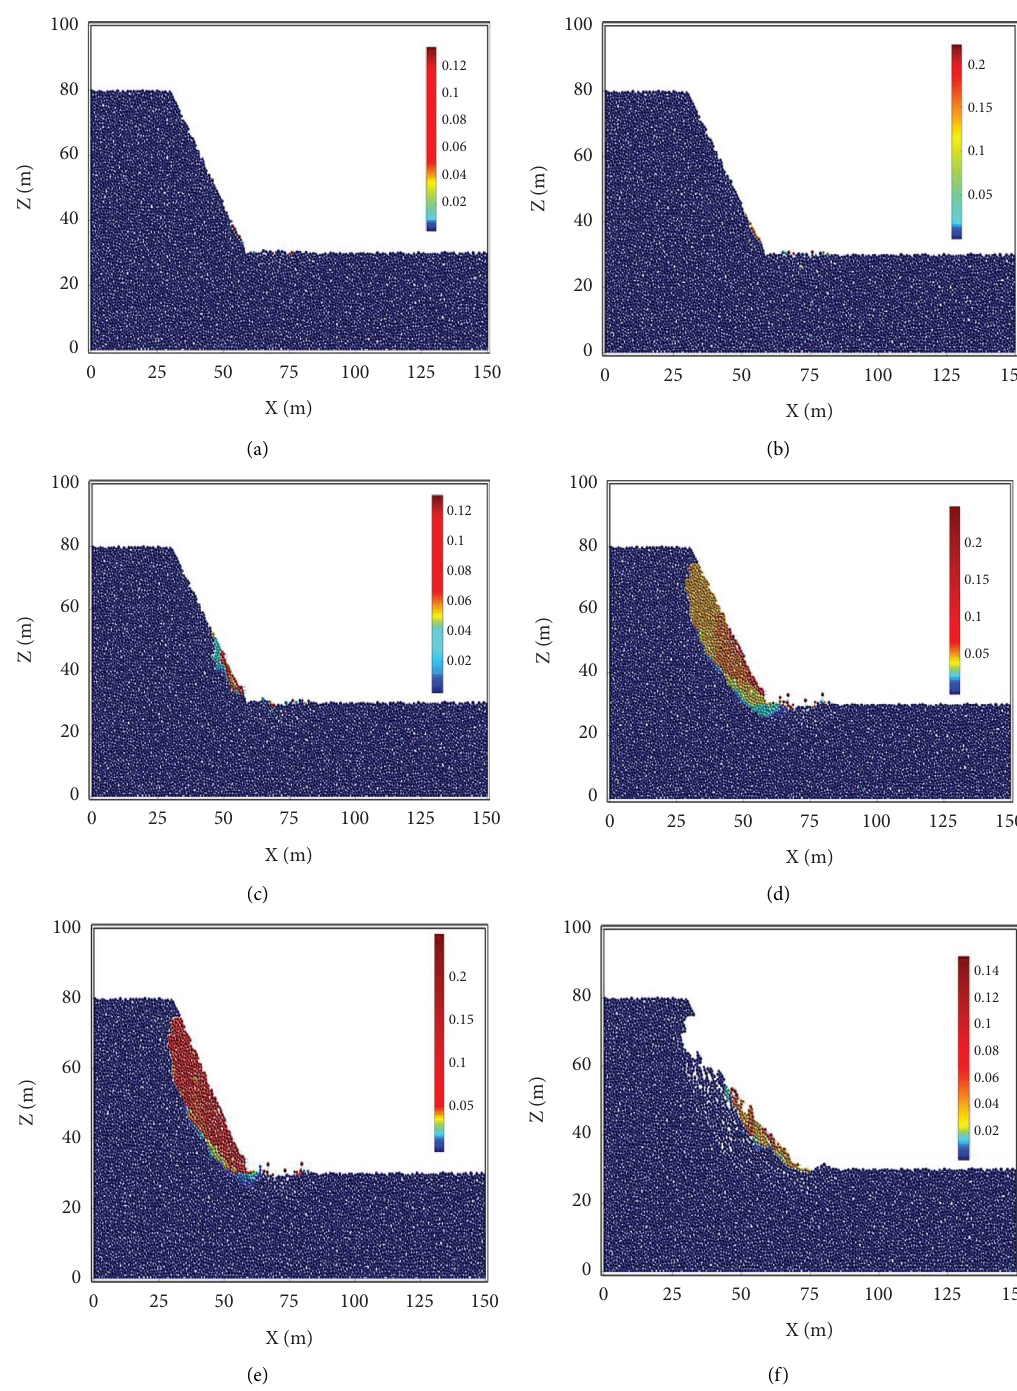
Figure 9: Te efects of diferent ramming times on slope under the tamping energy of 8000kN · m. (a) Te frst time ramming; (b) the second time ramming; (c) the third time ramming; (d) the fourth time ramming; (e) the ffth time ramming; (f) the failure state of